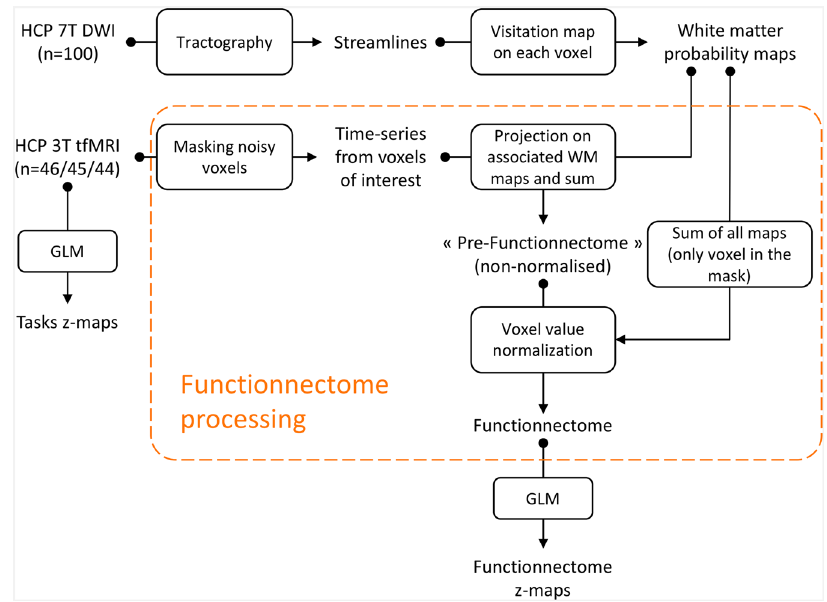
Fig. 7 Graphical summary of the neuroimaging work fl ow. Dashed orange lines delimitate the original part of the processing work fl ow called “ Functionnectome ” from other classical processing. Arrows indicate the direction of the work fl ow. Boxes correspond to the processing